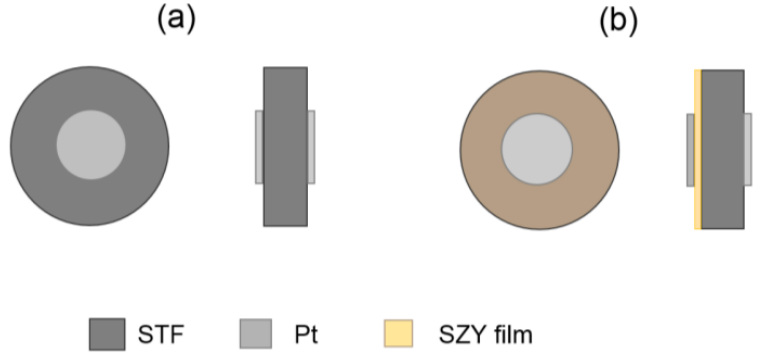
Figure 2. Schematic views of ( a ) Pt/STF/Pt and ( b ) Pt/SZY-film/STF/Pt cells.